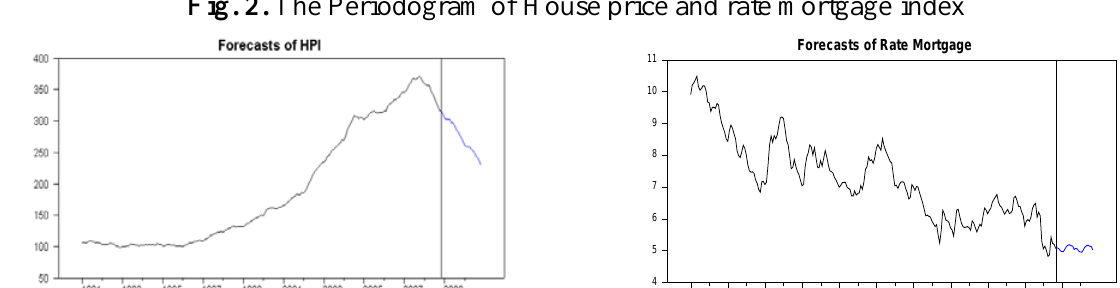
Fig. 2. The Periodogram of House price and rate mortgage index